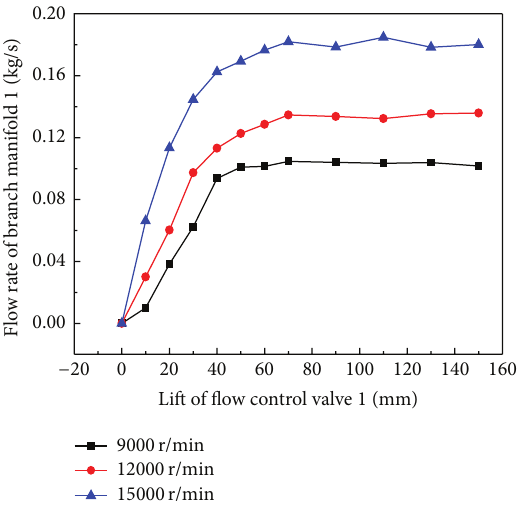
Figure 4: Flow rates in branch manifold 1.